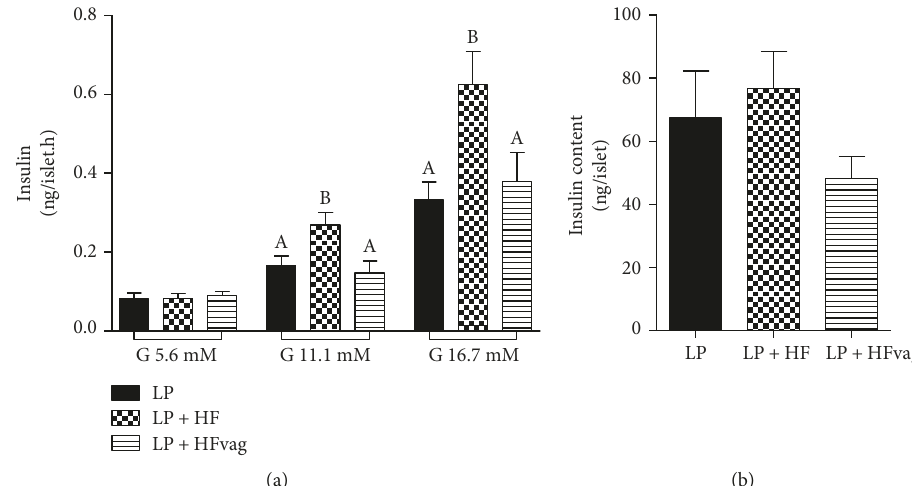
Figure 2: Vagotomy reduced GSIS in isolated pancreatic islets. Glucose-stimulated insulin secretion (a) and total insulin content (b) of islets from the LP, LP +HF, and LP +HFvag mice. Data are means ± SEM from the LP ( n = 13 ); LP + HF ( n = 8 ); and LP +HFvag ( n = 8 ). Di ff erent letters over the bars indicate signi fi cant di ff erences. One-way ANOVA followed by Tukey ’ s test. P < 0 05 .